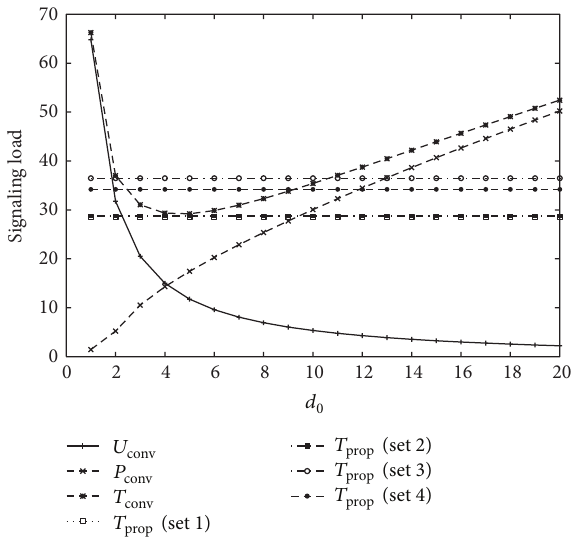
Figure6:Signalingloadfor 1/𝜆 𝑐 = 10.5∗2/3600(ℎ) (highmobility), 1/𝜆 = 10.5 ∗ 600/3600(ℎ) (long intersession idle